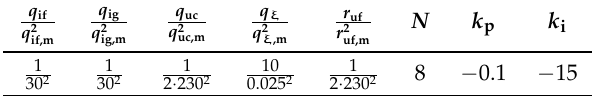
Table 3. Values of weighting